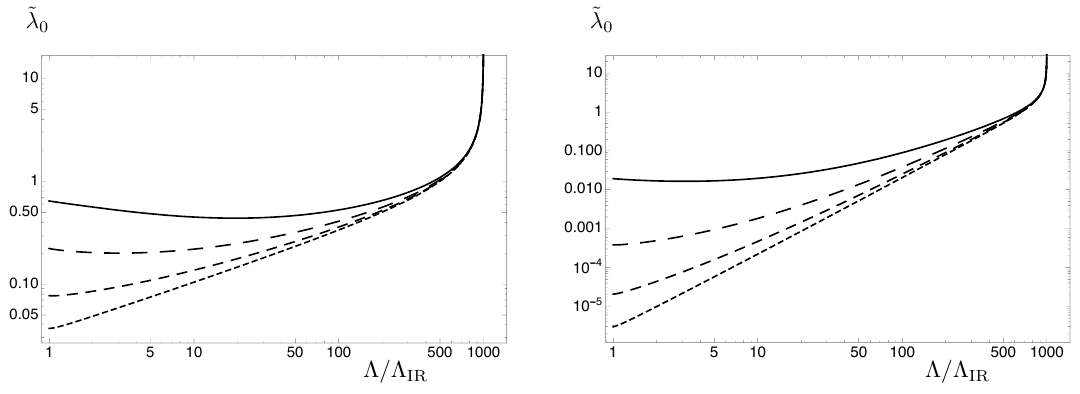
Figure 16 . Model II. The coupling ˜ λ 0 as a function of the energy scale Λ , for ∆ = 3 , x F = 1 , ∆ φ = 0 . 2 , y 5 = 0 , and ∆ R = 3 , 4 . 5 (left and right panels), for φ c = 1 , 2 . 5 , 3 . 3 , 3 . 7 (short-dashed to p solid lines). The maximum allowed value of φ c is given by 3 / ∆ φ ≈ 3 . 87 . The boundary condition for ˜ λ 0 is chosen such that, for all RG flows shown, the Landau pole is at Λ UV ’ 10 3 . Λ IR respective upper bounds. In contrast, the dependence of ˜ λ (max) on y , as seen from the 5 0 , IR right panel of figure 13, is qualitatively different: (i) the maximum IR value of the coupling does not approach ˜ λ (max) = 1 as a limiting case, and (ii) it is possible to suppress ˜ λ (max) 0 , IR 0 , IR even in the relevant case ∆ < 5 / 2 R